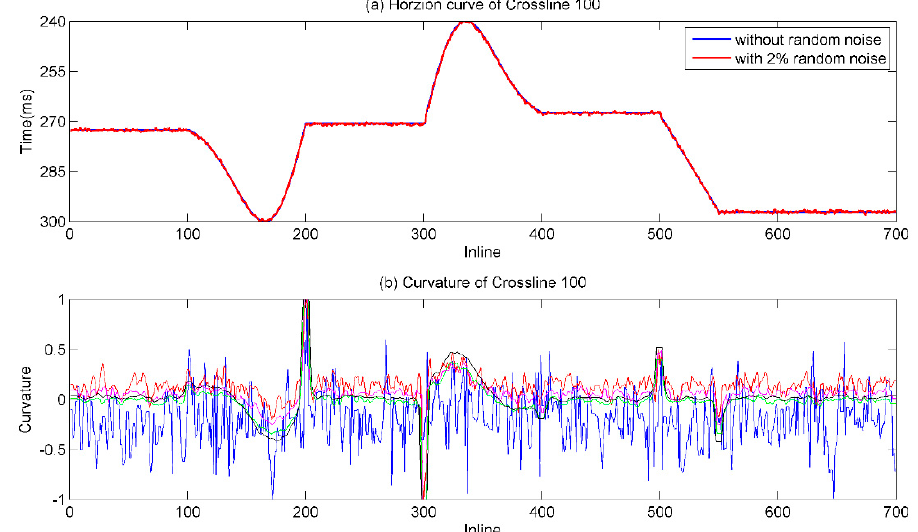
Figure 5. Horizon curve and mean curvature attribute with 2% noise: ( a ) Horizon curve and ( b ) mean curvature attribute of di ff erent time windows with 2% noise. Table 2. Correlation coe ffi cient for di ff erent time windows with 2%